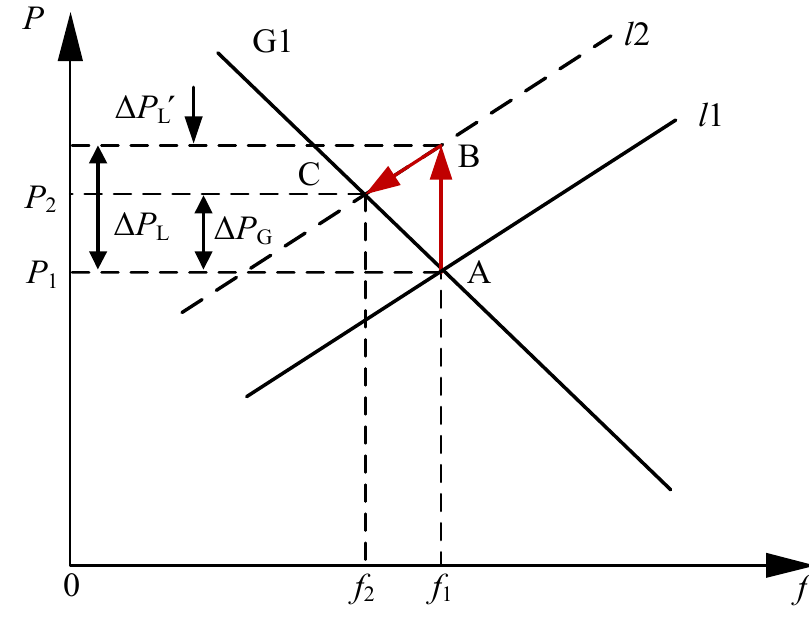
Figure 5. Integrated power-frequency static characteristics of the electric